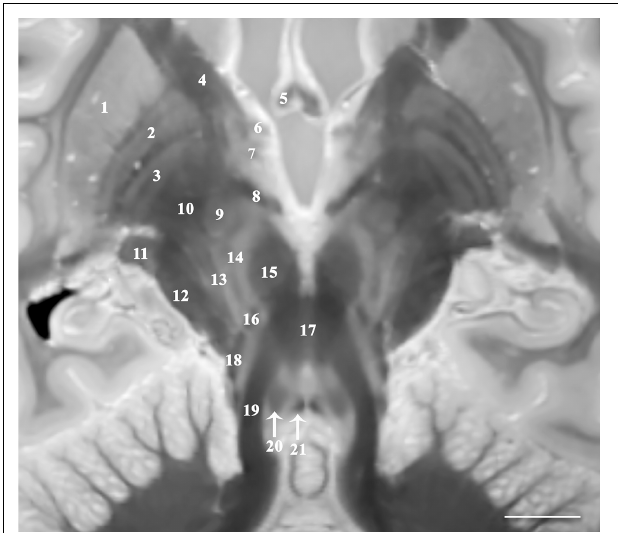
FIGURE 1 | Image parallel to the superior cerebellar peduncles and their decussation that is 33 o anterosuperior-to-posteroinferior oblique to the coronal intercommissural plane demonstrates relative spatial relationships of the midbrain, subthalamic and basal ganglia structures including putamen (1), globus pallidus externa (2) and interna (3), internal capsule (4), fornix (5), ansa peduncularis (6), ansa lenticularis (7), lenticular fasciculus (8), subthalamic nucleus (9) and fasciculus (10), lateral geniculate nucleus (11), cerebral peduncle (12), pallidonigral/corticonigral/nigrostriatal tracts (13), substantia nigra (14), red nucleus (15), medial leminiscus (16), decussation of superior cerebellar peduncles (17), spinothalamic tract (18), superior cerebellar peduncles (19), central tegmental tract (20), and medial longitudinal fasciculus (21) [scale bar = 10 mm]. Note multiple internal lamina of the globus pallidus.